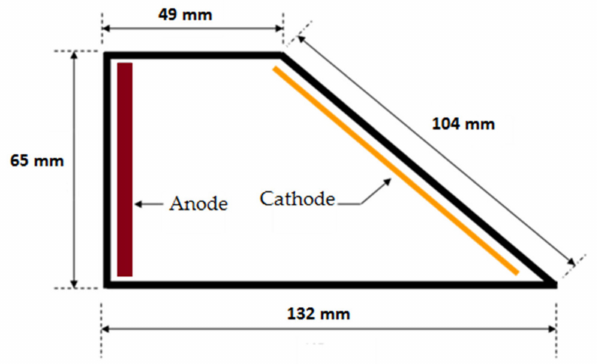
Figure 1. Top view of the 250 mL Hull cell used in this